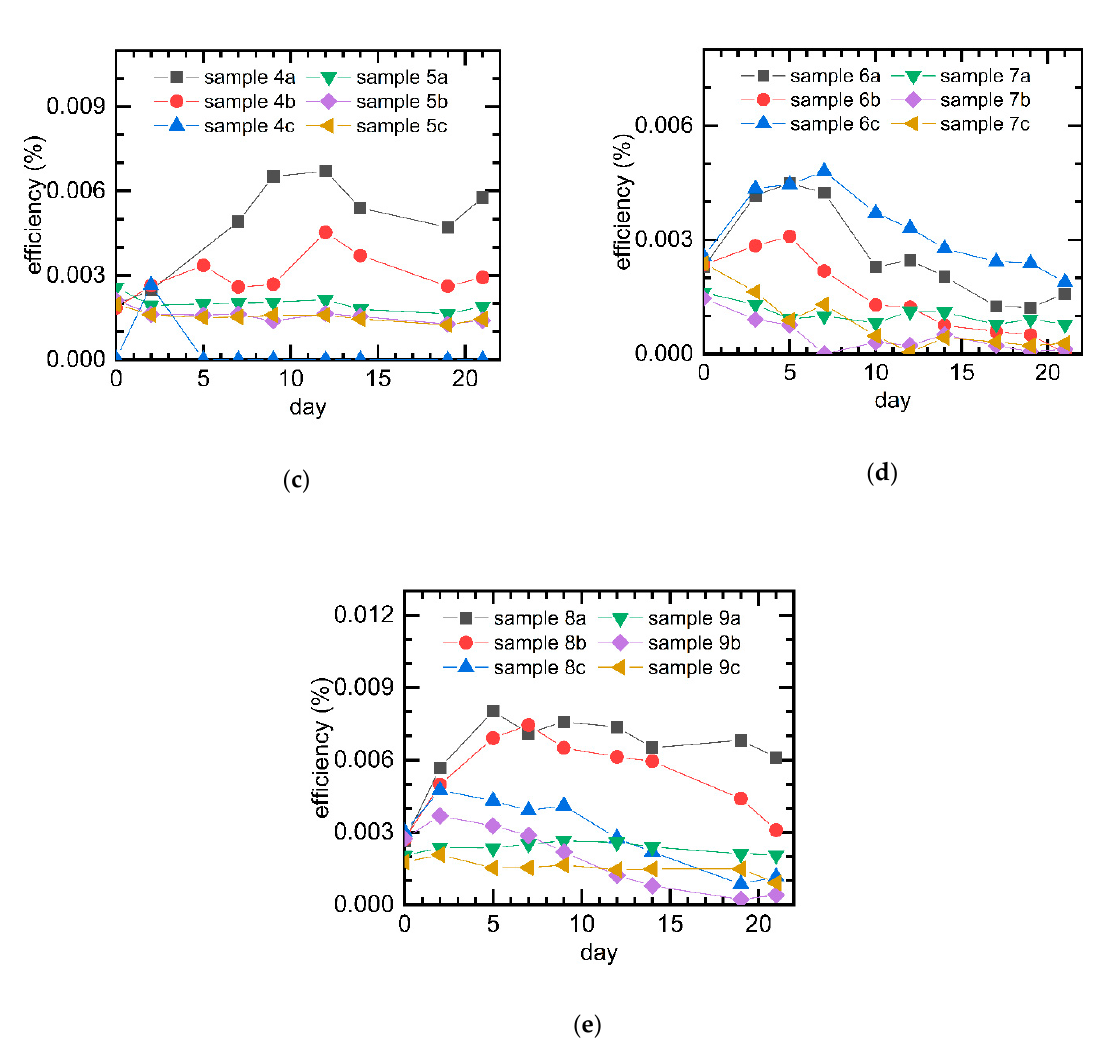
Figure 1. Efficiency progressions over the first 21 days of the three assembled DSSCs per sample: ( a ) sample 1 (PAN/PEO GPE) and the reference (commercial liquid electrolyte); ( b ) sample 2 (PAN/PEO GPE with different ratio) and sample 3 (PAN GPE); ( c ) sample 4 (ABS/PEO GPE) and sample 5 (ABS GPE); ( d ) sample 6 (PVA/PEO GPE) and sample 7 (PVA GPE); ( e ) sample 8 (PVDF/PEO GPE) and sample 9 (PVDF GPE). The letters “a” to “c” indicate the different DSSCs per sample, where “a” denotes the best DSSC studied over 120, respectively.